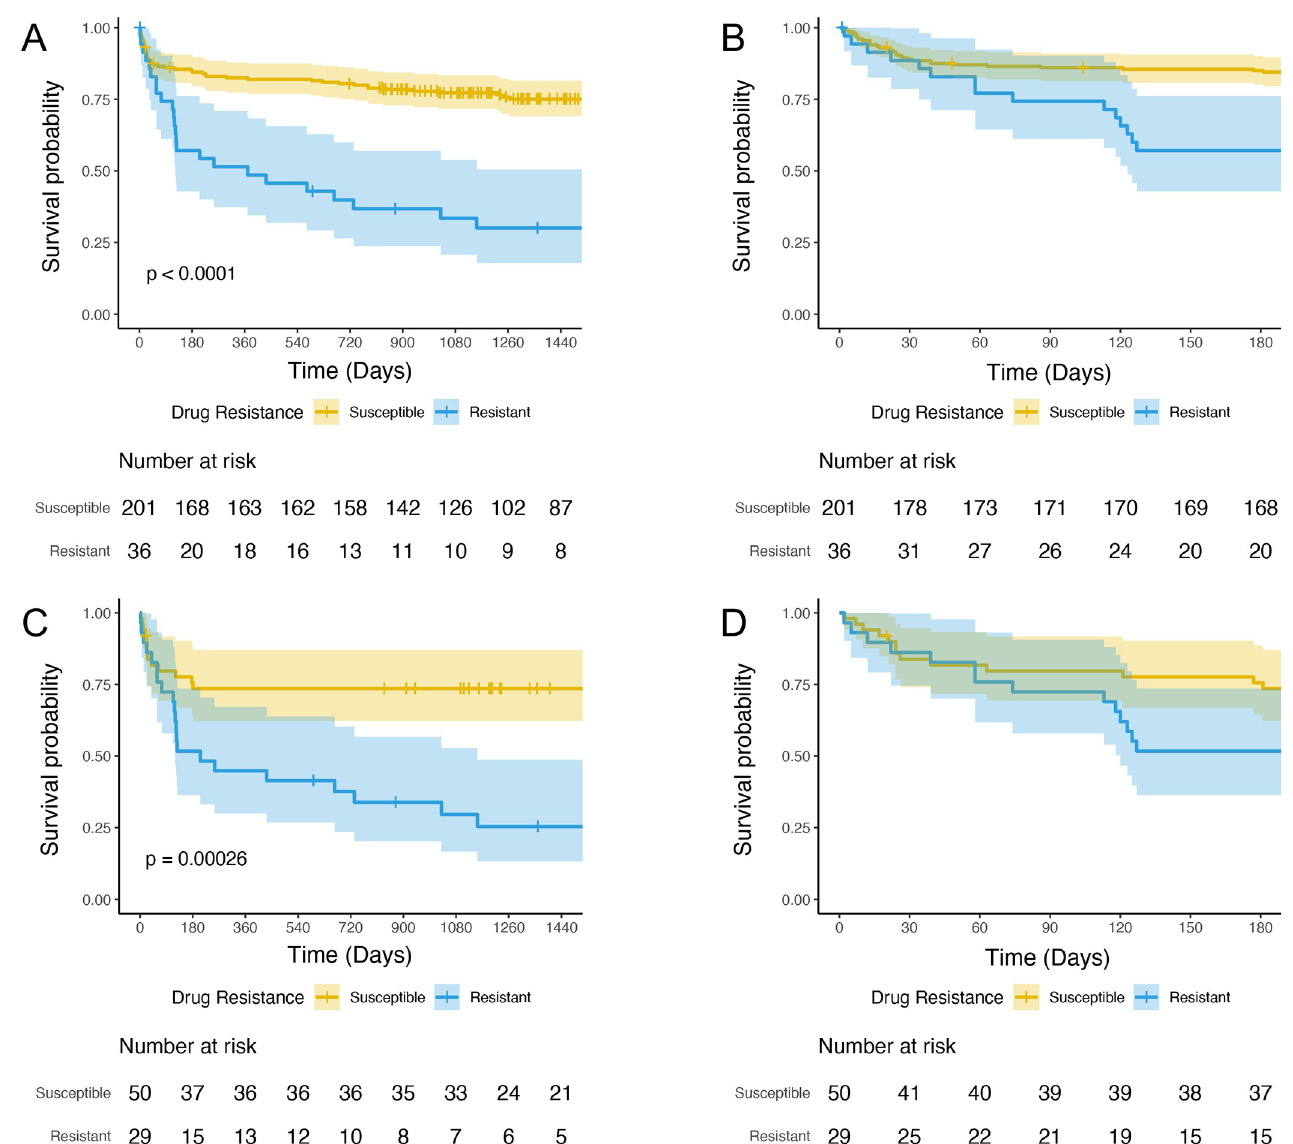
Fig 2. Kaplan Meier survival curves for (A) all patients treated for tuberculosis meningitis (TBM; n = 237) over the full period of observation and (B) over first 6 months. (C) Probable and definite TBM cases (n = 79) over the full period of observation and (D) over first 6 months of treatment. Mortality in persons treated for drug susceptible-TBM is depicted by the yellow line and for persons with drug resistant-TBM by the blue line. The shaded region surrounding the line depicts the 95% confidence interval of the mortality estimate.